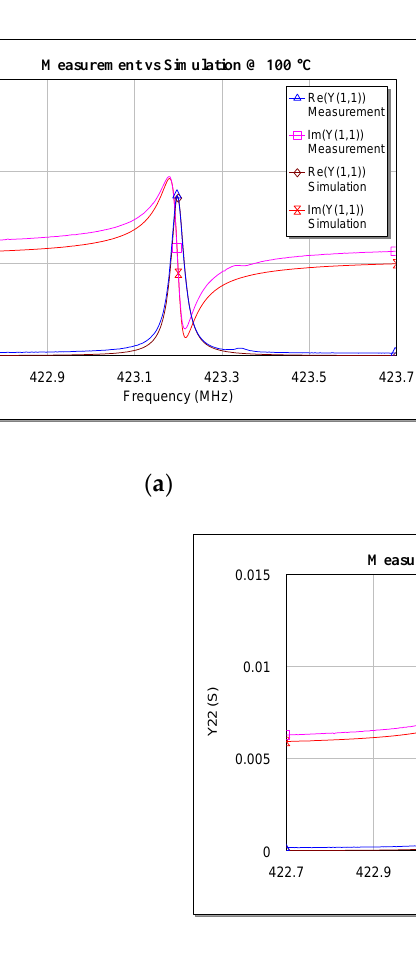
Figure 11. Comparison between measurements and simulations of the real and imaginary parts of ( a ) Y 11 , ( b ) Y 21 , and ( c ) Y 22 versus the frequency for the tested SAW resonator at 100 °C.